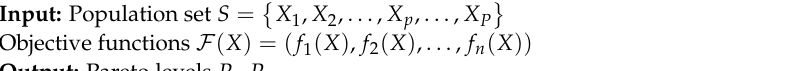
Algorithm 1: Fast non-dominated sorting algorithm for MoQGA